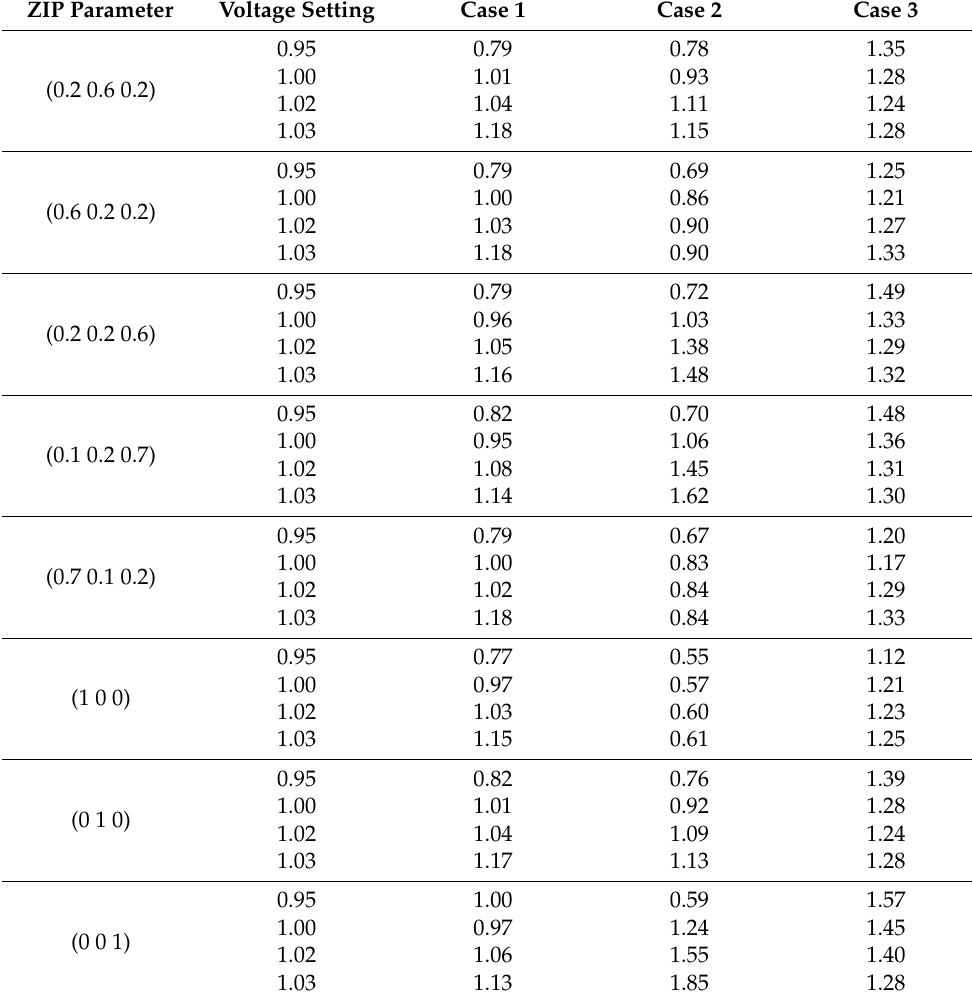
Table 10. RMS error for active power loss estimation for function 1 for IEEE-34 bus